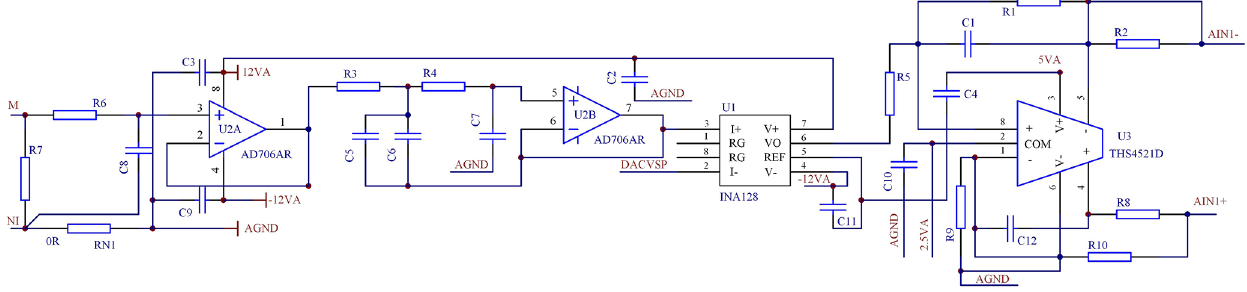
Figure 5. Schematic of the MN channel on the AB. Table 1. Comparison of instrument performance indicators.